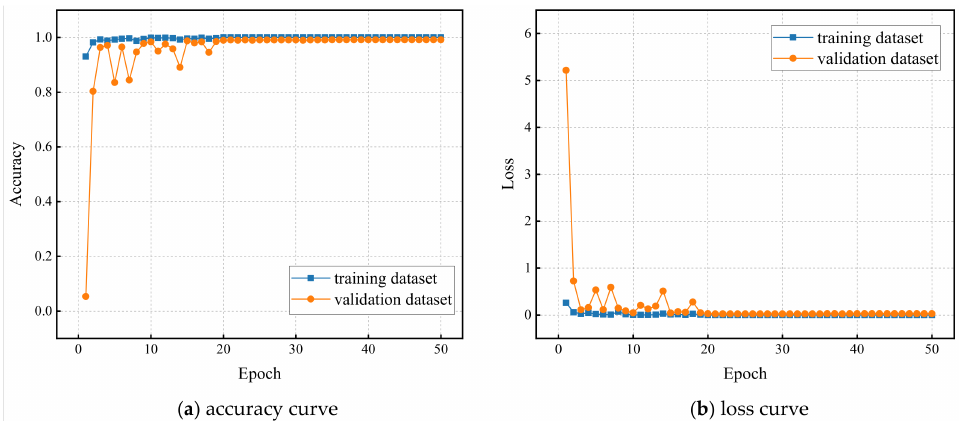
Figure 7. Training curve of the proposed